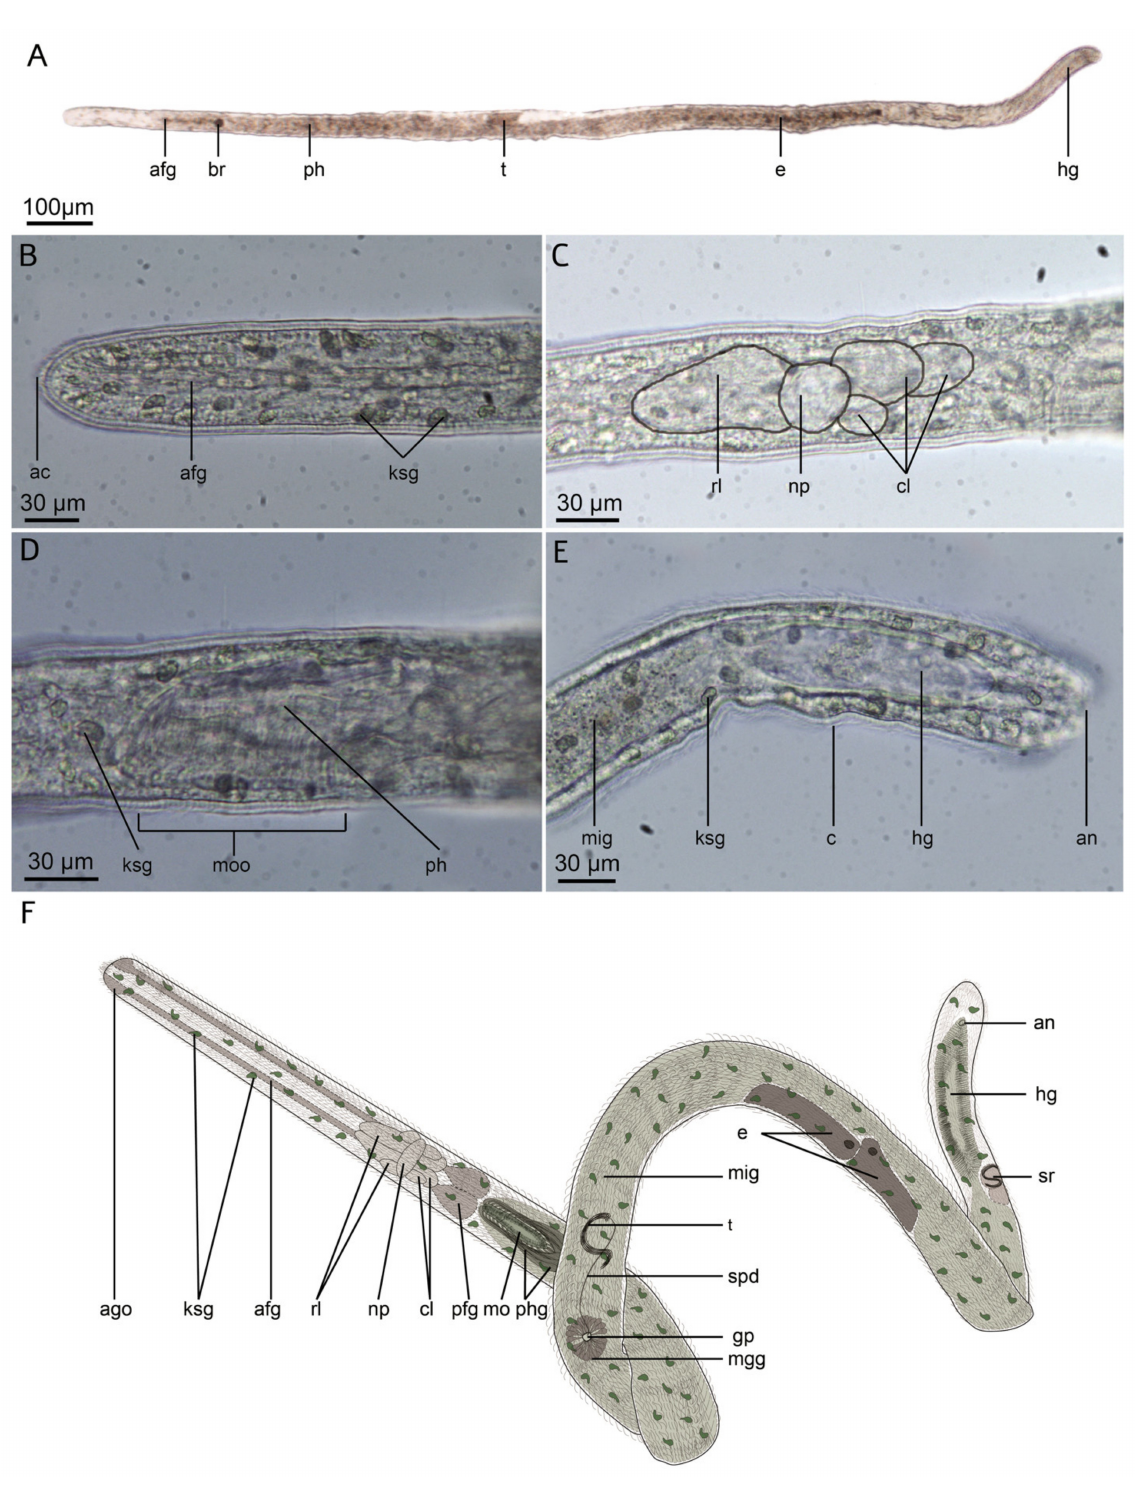
Figure 6. Morphology of Lobatocerebridae with illustrations of Lobatocerebrum riegeri (b–f, modified from [15]). Anterior is to the left and posterior is to the right. ( A , B , F ) Dorsal view. ( C , D ) Lateral view, ventral is down, and dorsal is up. ( A – E ) Light micrographs of L. riegeri. ( A ) Habitus of L. riegeri. ( B ) Close up of the tip of the rostrum. ( C ) Close up of the brain. ( D ) Close up of the mouth area. ( E ) Close up of the posterior end. ( F ) Schematic drawing of L. riegeri . Abbreviations: ac, anterior ciliation; afg, anterior frontal glands; ago; anterior frontal gland opening; an, anus; br, brain; c, body ciliation; cl, caudal lobe(s) of the brain; e, egg; gp, gonopore; hg, hindgut; ksg, kidney shaped glands; mgg, male gonopore glands; mig, midgut; mo, mouth; moo, mouth opening; np, neuropil; pfg, posterior frontal glands; ph, pharynx; rl, rostral lobe(s) of the brain; spd, spermioduct; sr, seminal receptacle; t,